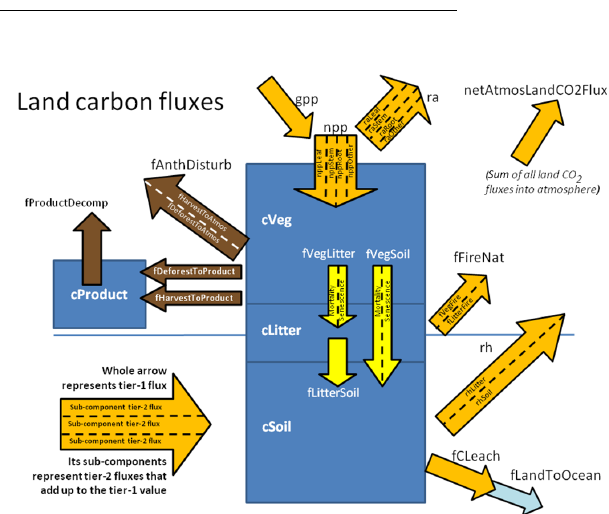
Figure 6. Requested tier-1 and tier-2 variables representing land carbon fluxes. The colours of the arrows correspond to the type of flux. The orange arrows represent “natural” fluxes that represent pathways of carbon exchange between the land and